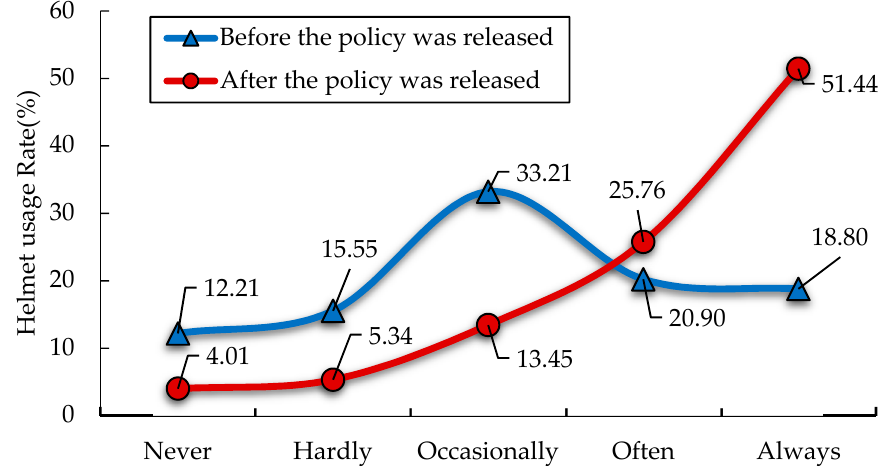
Figure 5. Distribution of helmet usage in Ningbo, China. Table 5. Estimated results of the BOP